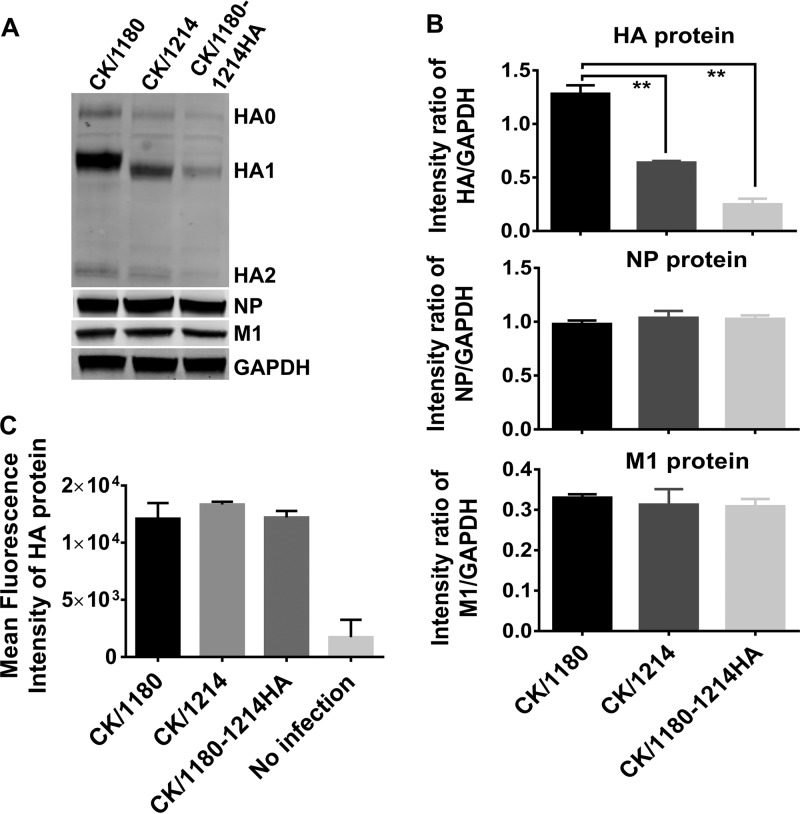
Expression of viral proteins in infected MDCK cells. MDCK cells were infected with viruses at an MOI of 5. The infected cells were collected at 12 h postinfection, lysed in SDS loading buffer, and further analyzed by Western blotting (A and B). (A) Protein bands of HA, NP, and M1 proteins detected by Western blotting. The intensity of each band was measured by using ImageJ software, and relative intensity ratios of HA, NP, and M1 compared with that of GAPDH were calculated (B). The infected cells were digested with trypsin to obtain a single cell suspension at 12 h postinfection. The samples were stained with rabbit monoclonal antibody to influenza A virus H5N1 HA protein and Alexa Fluor 488-conjugated goat anti-rabbit IgG (H+L) secondary antibody and then detected on a FACSAria II (BD Biosciences). (C) Mean fluorescence intensity of HA protein was analyzed with FlowJo X 10.0.7r2 (Tree Star, San Carlos, CA). Data are presented as means ± SD (n = 3). **, P < 0.01 (Student's t test).